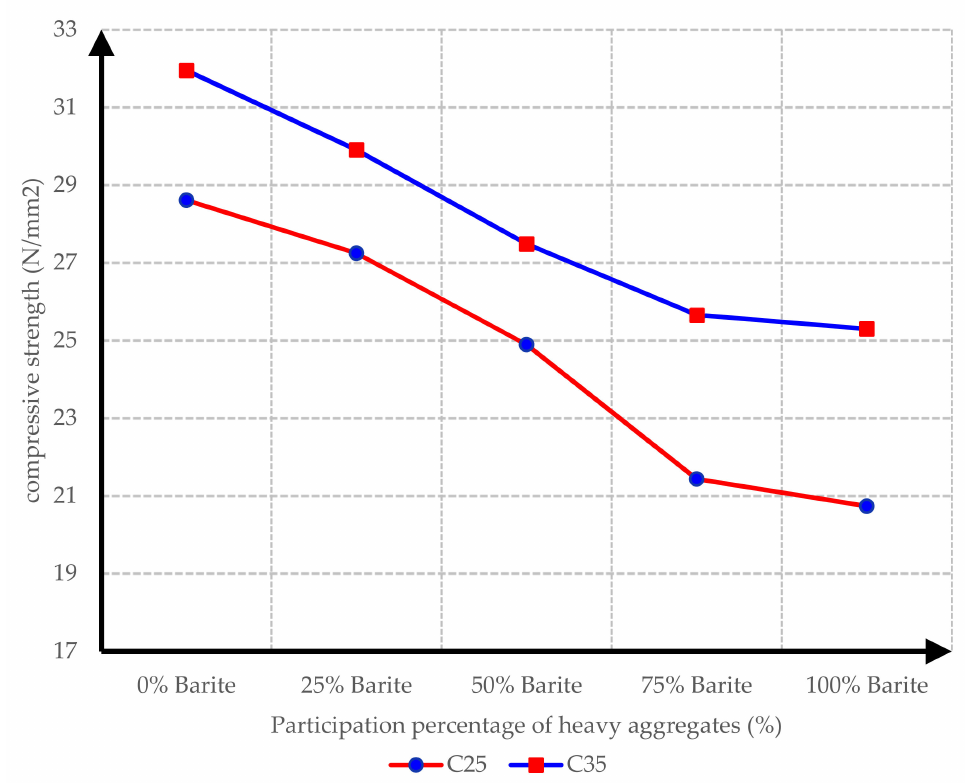
Figure 8. Diagram of compressive strength of concrete specimens and participation percentage of barite aggregates for C25 and C35 concrete